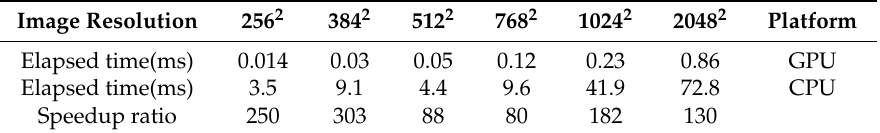
Table 4. Elapsed time of images with different resolution ( cameraman ).